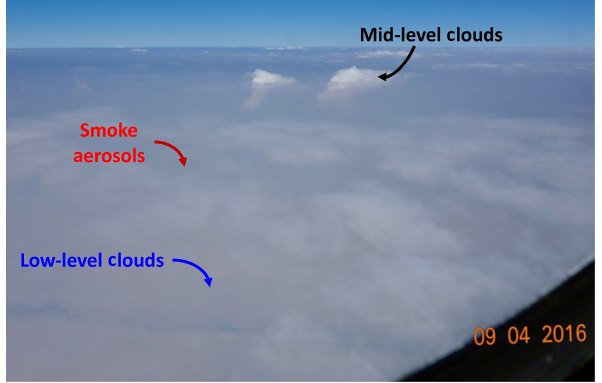
Figure 1. An Image taken during the NASA ORACLES Field cam- paign on 4 September 2016, showing mid-level clouds and smoke above the low-level clouds. Image taken by Paquita